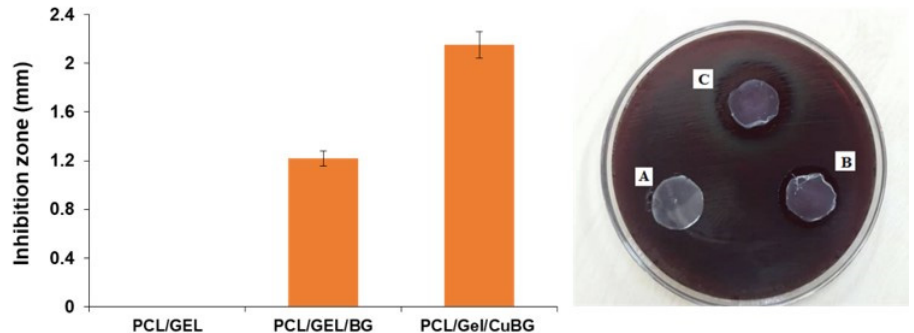
Figure 3. Antibacterial activity of the membrane. The inhibition zones of PCL/Gel, PCL/Gel/BG, PCL/Gel/CuBG scaffolds against porphyromonas gingivalis after 24 h incubation are shown in A, B, and C, respectively.